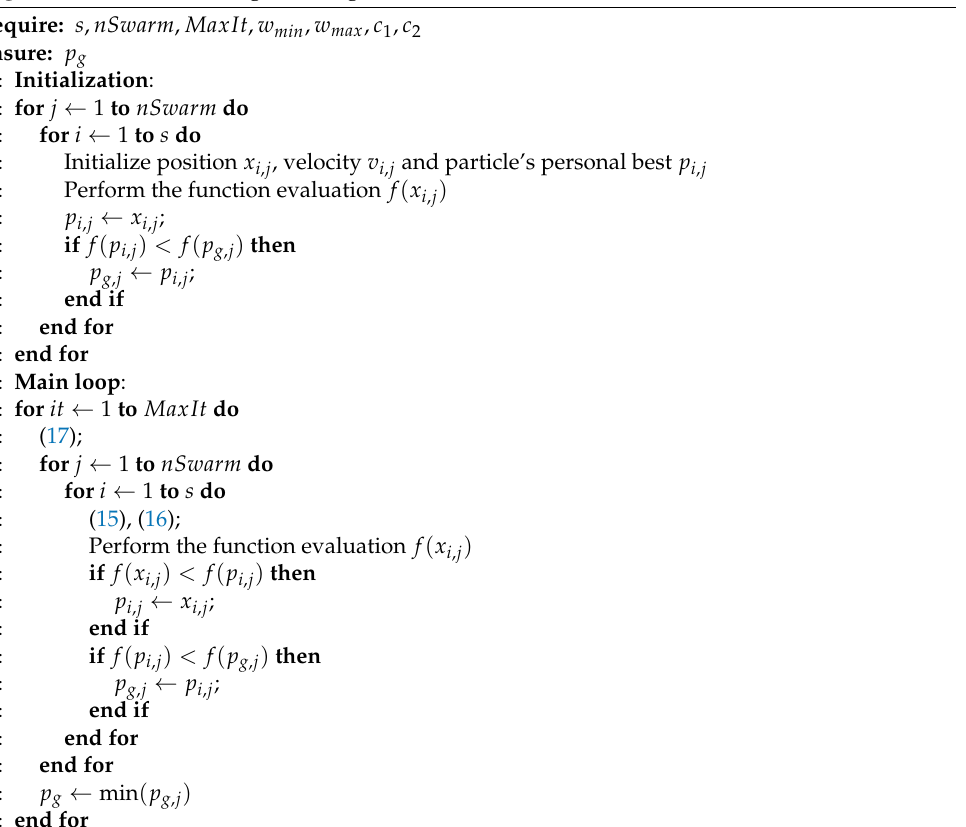
Algorithm A3 MSPSO